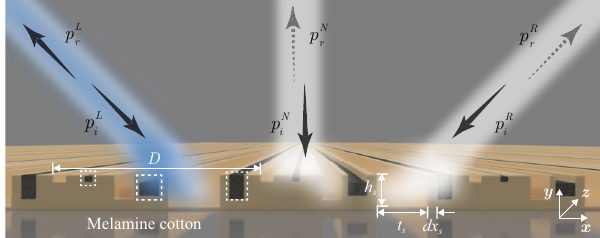
Fig. 1 Schematic diagram of a non-local and non-Hermitian acoustic metagrating at the higher-order exceptional point. This metagrating is composed of six surface-etched grooves in a period ( D ). The global response of the metagrating to the external excitation can be engineered by tuning the groove depth ( h s ), width ( t s ), and the spacing ( dx s ), where s is the index of groove in a period ( s = 1, 2, ..., 6). The variation of dx s can be used to tune the non-local interaction between grooves. White and blue rays show the channels with strong and eliminated retro-re fl ection, respectively. The propagating waves are represented by black arrows, while the suppressed waves are indicated by gray dashed arrows. p is the complex pressure amplitude, whose superscript indicates the left (L), normal (N) and right (R) channels of the grating, and the subscript refers to the re fl ection ( r ) and incidence ( i ). In each period, three grooves are fi lled with sound-absorbing materials (melamine cotton) to introduce loss, as marked by white dashed